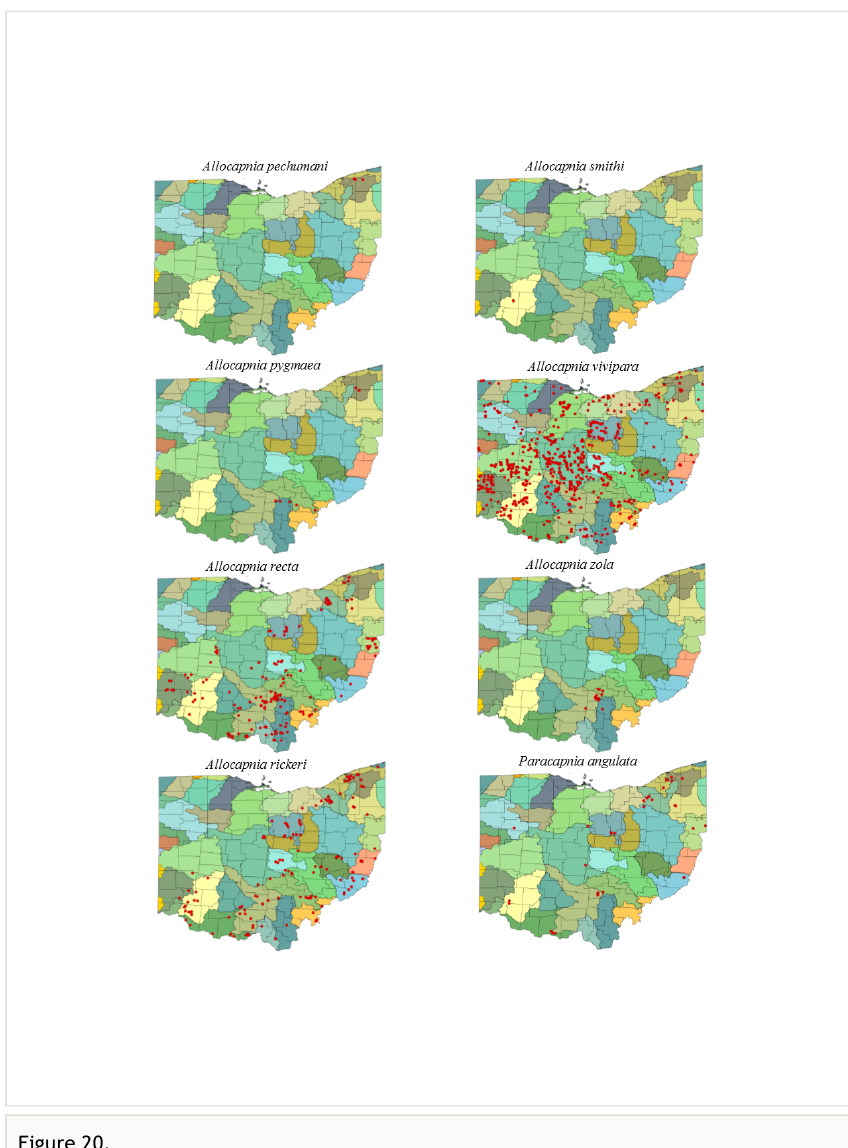
Figure 20. Distribution of Capniidae in